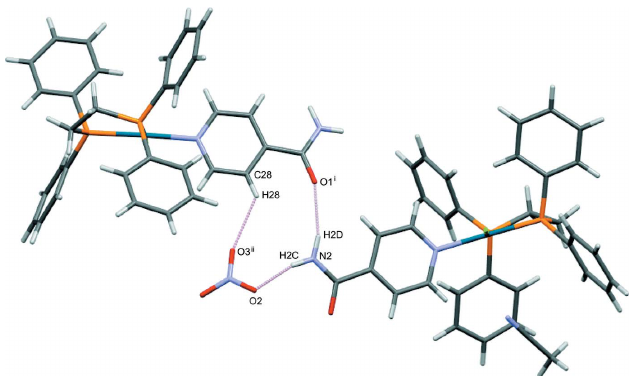
Figure 3 Capped sticks representation of the title compound showing the hydrogen-bond interactions (pink).